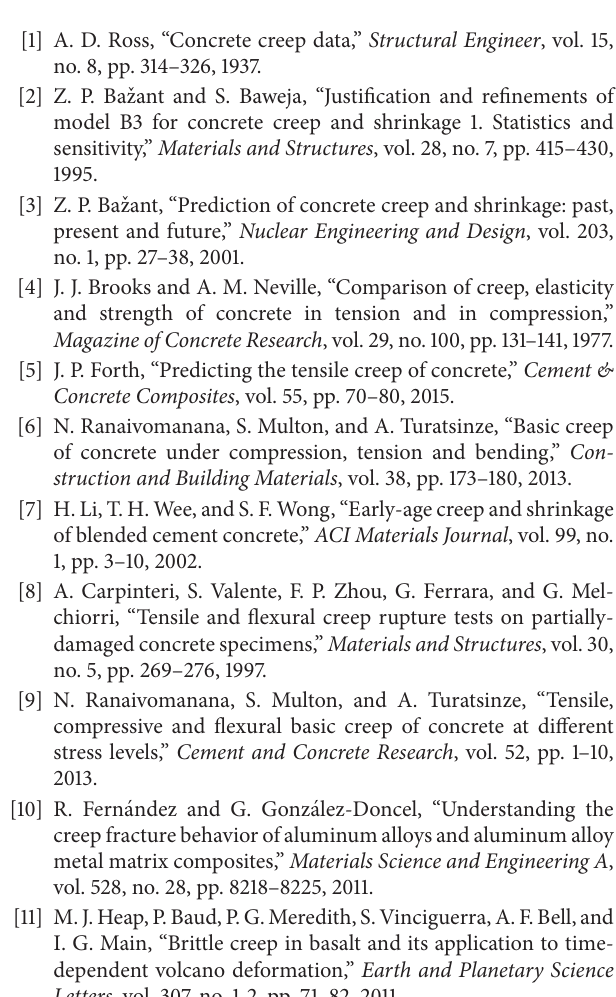
Figure 9: The log-log plot of the creep slopes 𝜆 𝑠 of the secondary stageand (𝜀 𝑓 −𝜀 0 )/(𝑡 𝑓 −𝑡 0 ) .Itisindicatedthatthereisanalmostlinear relation; namely, the solid straight line is the fitted result. So, the lifetime (𝑡 𝑓 − 𝑡 0 ) for each specimen shows a power-law dependence on the secondary creep rate with an exponent of −